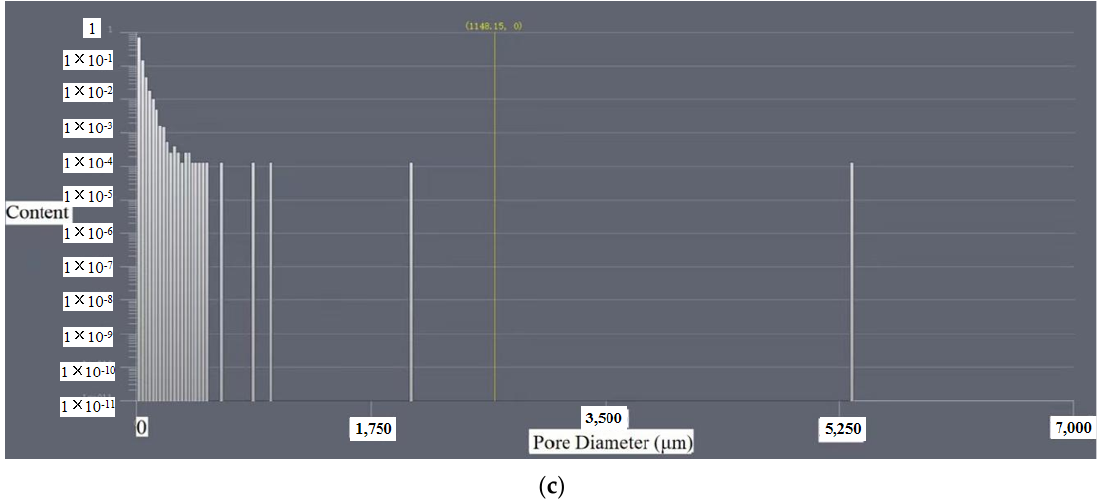
Figure 13. Reconstructed pore structure model of FR UHPC (above 200 μm): ( a ) Analysis of pore structure characteristics. The І was the whole structure, Ⅱ was the upper area and Ⅲ was the bottom area; ( b ) Top view of pore structure; ( c ) Pore size distribution of FRUHPC.